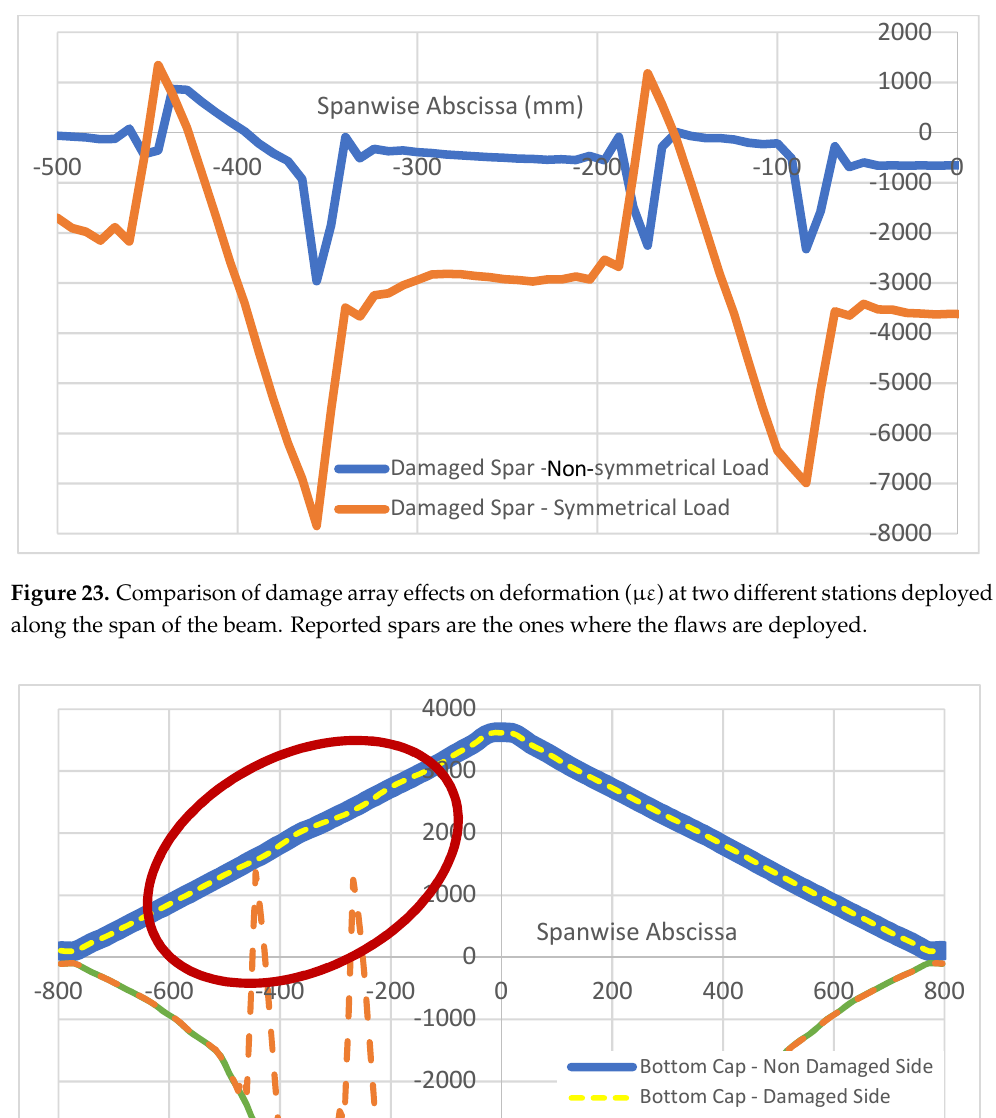
Figure 25. Strain difference function (με) between left and right bottom caps, retrieved within the bonding line. Red circles indicate approximate positions of the applied debonding at the top cap. These preliminary investigations on the reference test article make it possible to state the strong localization characteristics of the debonding defects. It is almost consequential, then, to explore the effects of a flaw insisting on a partial spanwise region of the cap, i.e., non-extended over the entire cap width. This analysis is devoted to verifying the actual possibility of observing the presence of debonding by means of a dense sensor array that may or may not cross the flaw area. In this case, a very small adhesive imperfection is implemented at the limits of the numerical mesh discretization, sized 16 × 8 mm spanwise vs. cap-wise. As for the other analyses, the optical fiber is simulated within the bonding layer of the C-spar, towards the interior of the composite beam section. The irregularity was moved along the cap width in five different positions so as to cover its entire width, moving from the external to the internal part (Figure 26). The results are shown below (Figure 27), where the only deformation difference is reported between the acquisition